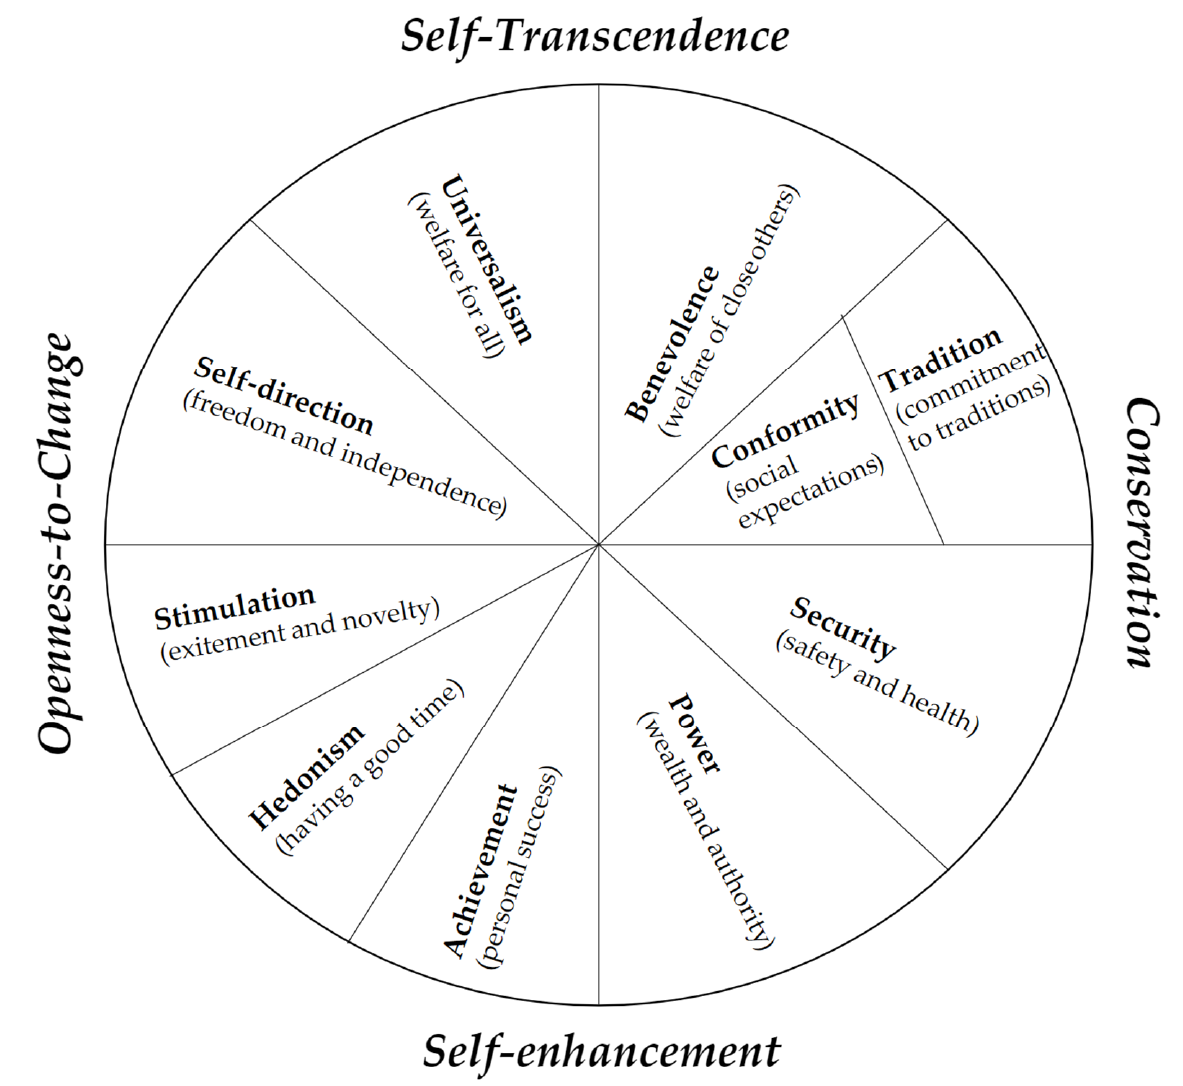
Figure 1. Human Values Framework, reprinted from Schwartz [24] with permission from Elsevier. The circumplex structure shows the compatibilities between adjacent values (e.g., universalism and benevolence) and oppositions between conflicting values (e.g., universalism and power). The labels outside the circumplex refer to combinations of values that are seen as higher order values (e.g., openness to change and conservation).